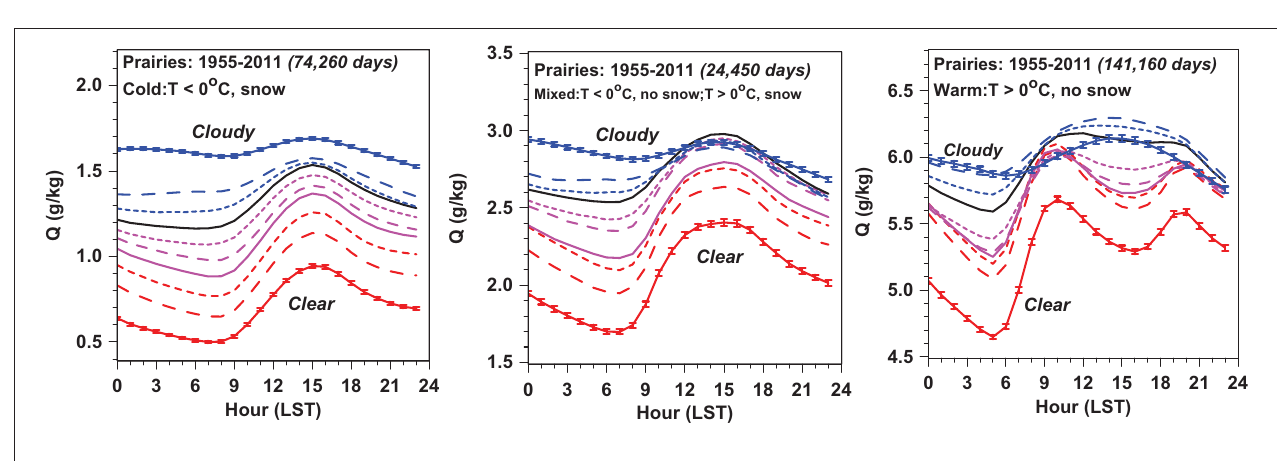
FIGURE 8 | As Figure 7 for RH and P LCL .